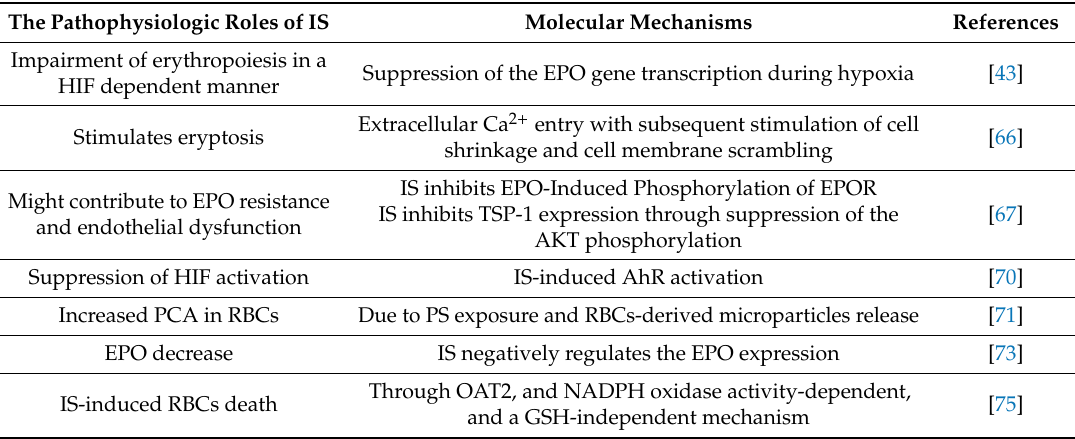
Table 3. Role of IS in the regulation of renal